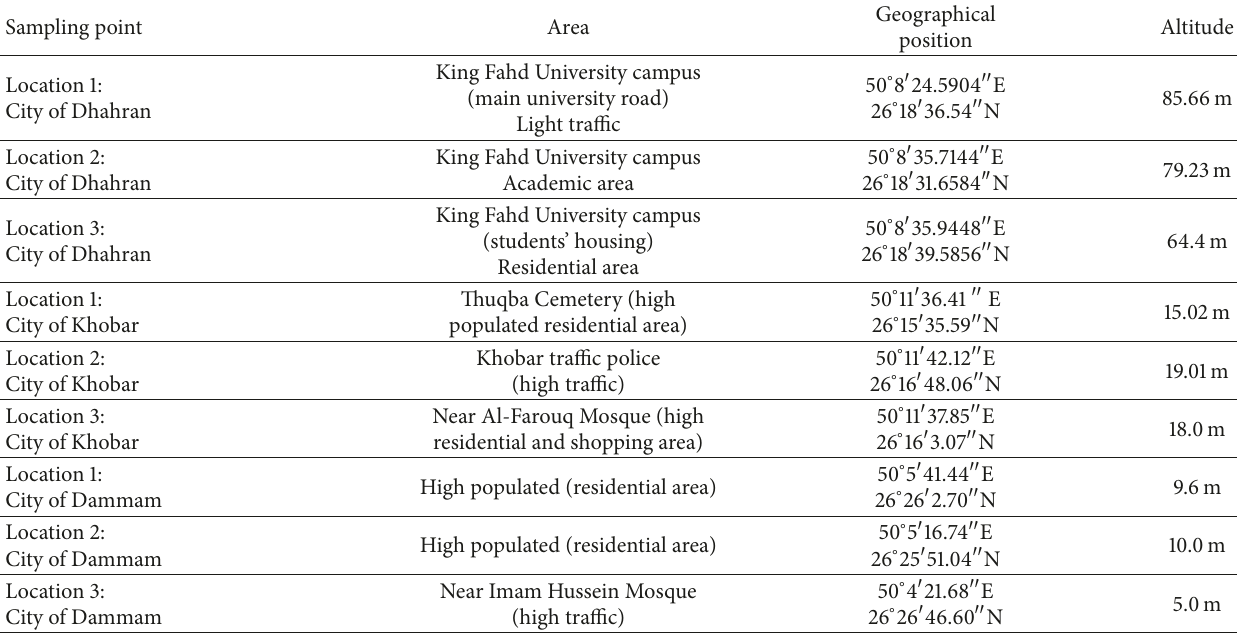
Table 1: Information on the sampling areas in Dhahran, Khobar, and Dammam. Sampling